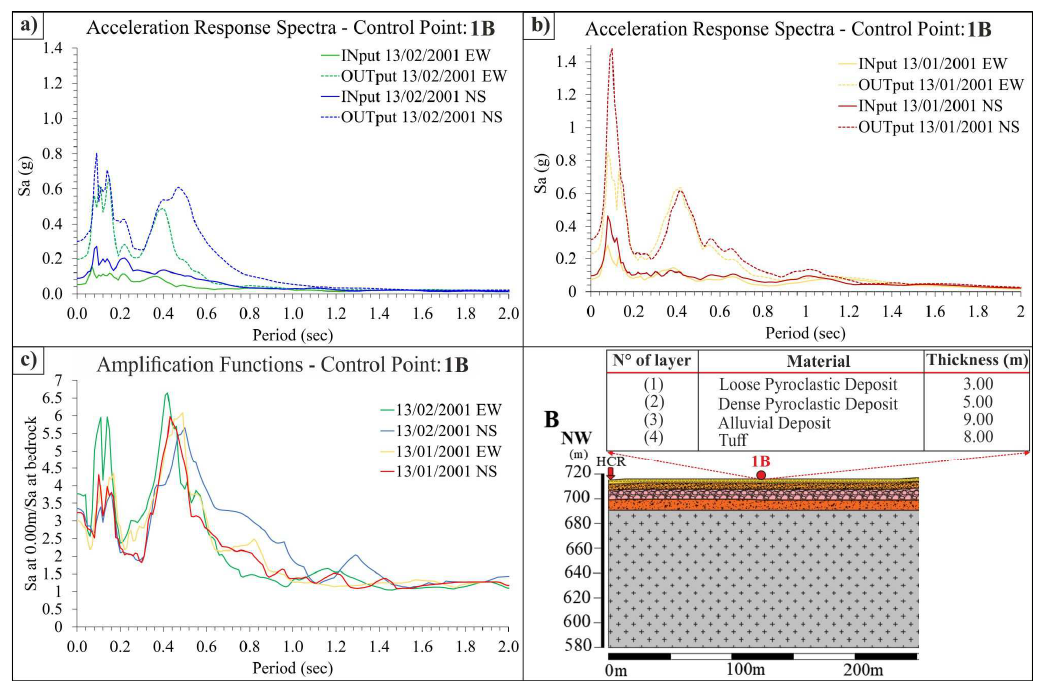
Figure 18. Section BB′: numerical control point 1B spectral responses obtained by 2D numerical analyses using LSR2D software. ( a ) Comparison among the SA of the two components of the 13 February 2001 earthquake. ( b ) Comparison among SA of the two components of the 13 January 2001 earthquake. ( c ) Amplification functions related to the four input motions.